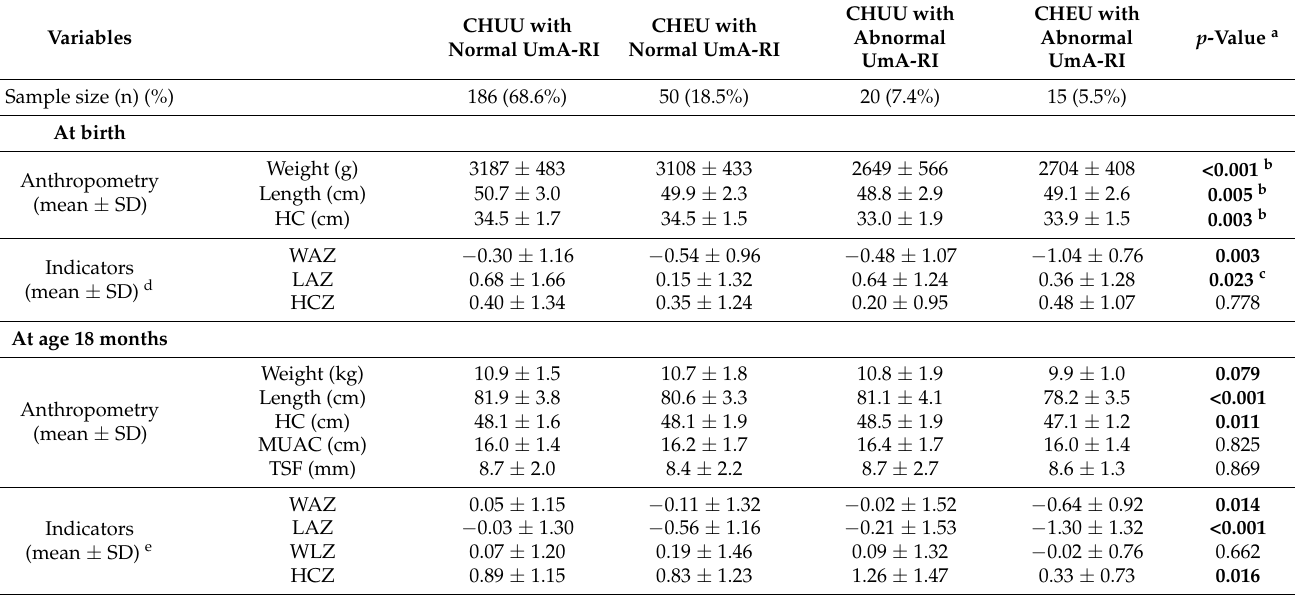
Values in bold font indicate significant p -values. Abbreviations: CHEU: children who are HIV-exposed-uninfected; CHUU: children who are HIV-unexposed-uninfected; UmA-RI: umbilical artery resistance index; WAZ: weight- for-age z-score; LAZ: length-for-age z-score; WLZ: weight-for-length z-score; HCZ: head circumference z-score. a Sex-normalized anthropometric indicators at age 18 months were computed using the World Health Organization (WHO) Anthro software of 2011, corrected for gestational age for preterm infants. Table 4. The mean anthropometric measurements and indicators of study children at birth and age 18 months, as per groups of control, single exposure and dual exposure to maternal HIV plus abnormal